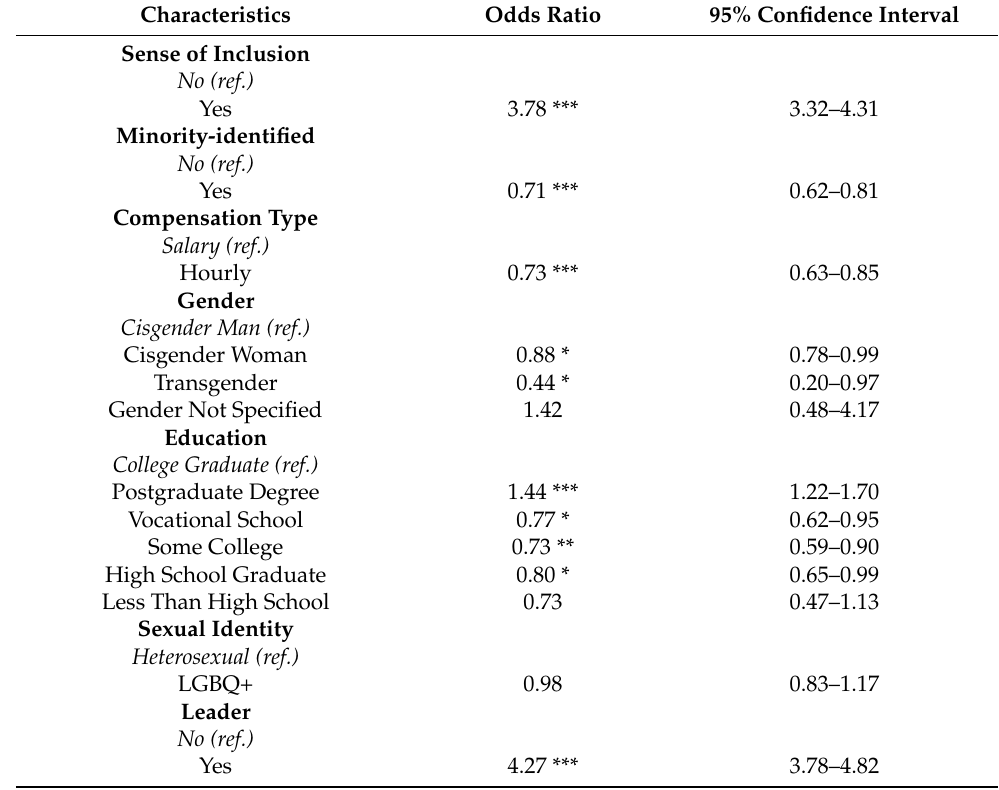
Table 3. Logistic Regression Results (Influence at Work